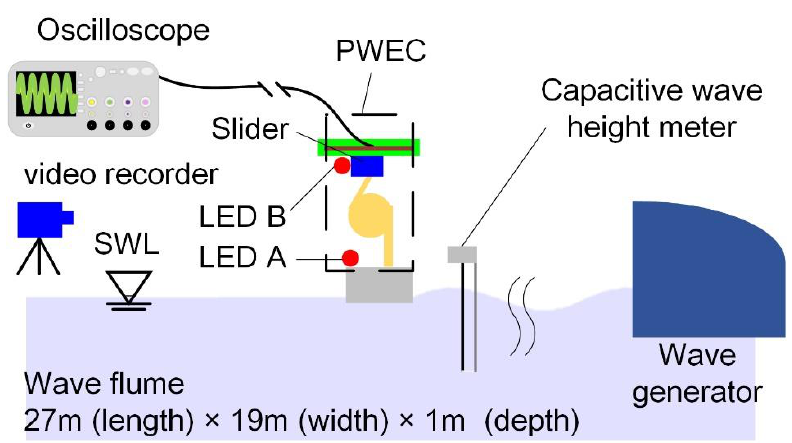
Figure 4. Schematic view of the experimental setup.